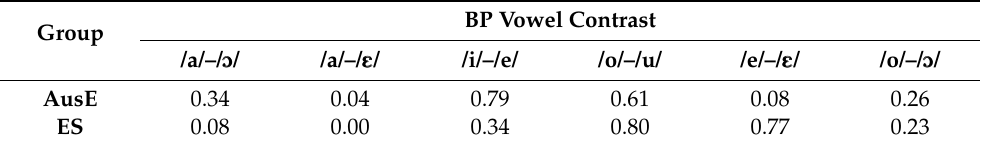
Table 3. Acoustic overlap scores for AusE and ES